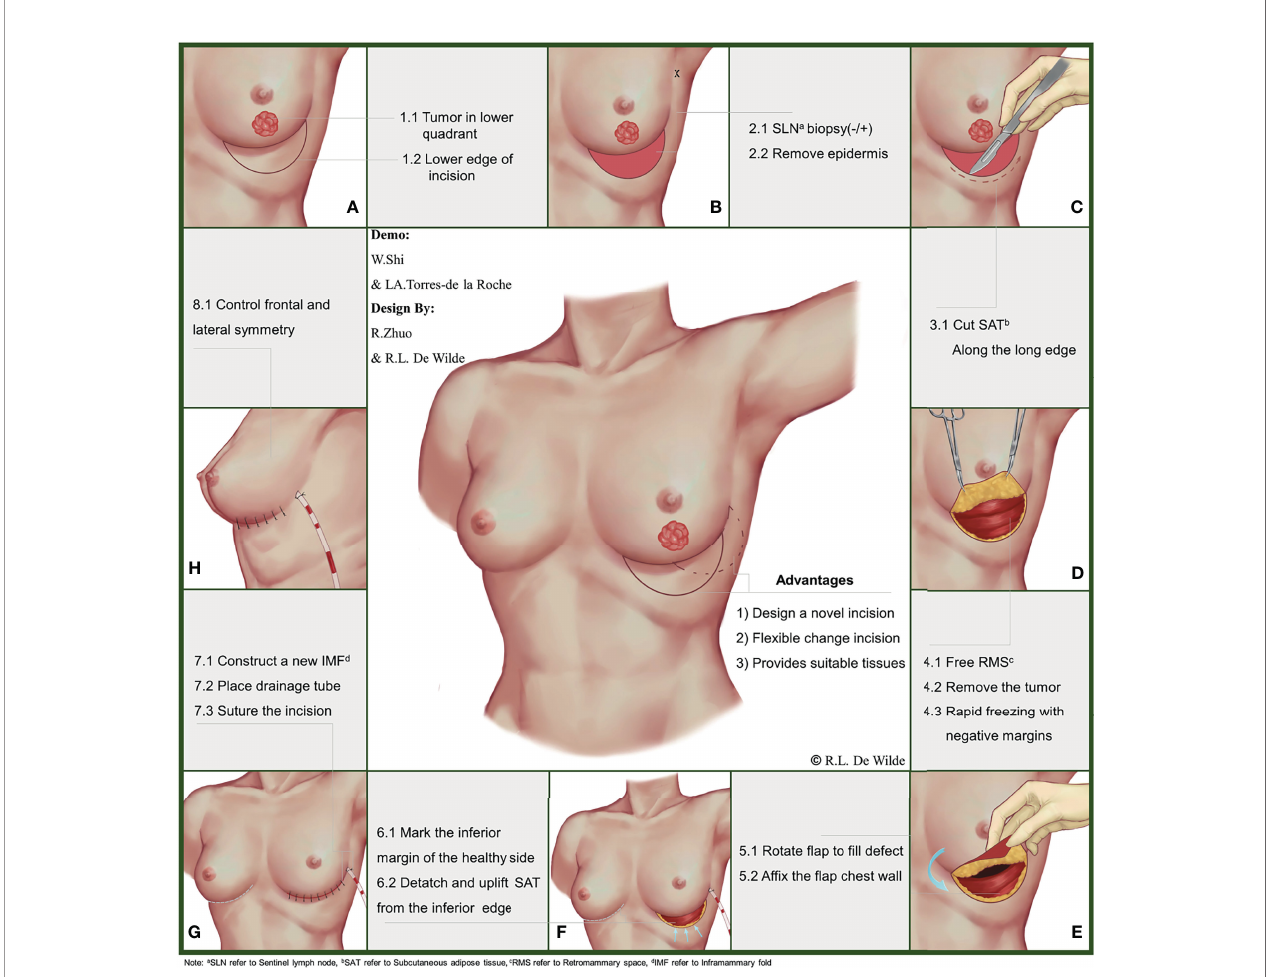
FIGURE 2 | Demo fi gure for the folding fl ap